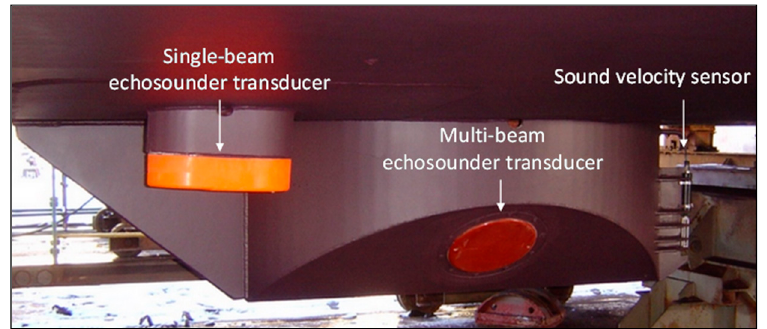
Figure 3. Under-keel blister with sound velocity sensor, single-beam, and multi-beam transducer.